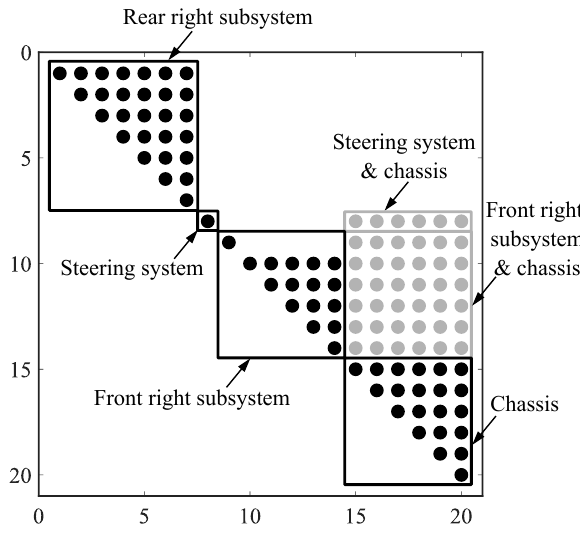
Figure 3. Path matrix of the 7-DOF vehicle multibody